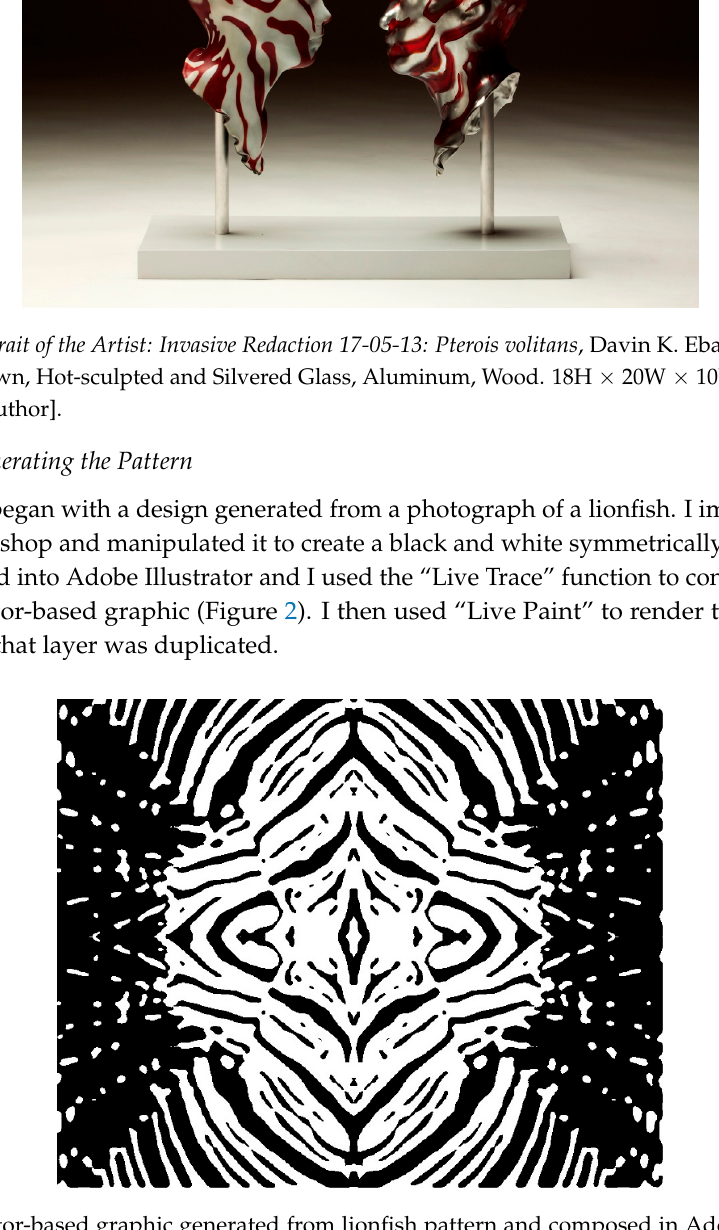
Figure 2. Vector-based graphic generated from lionfish pattern and composed in Adobe Illustrator. [Created by author].